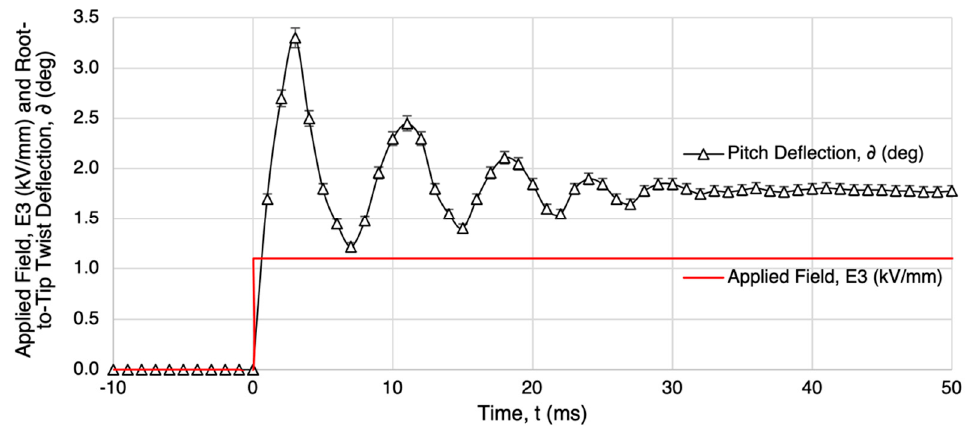
Figure 13. Root-to-tip DAP wing twist deflections with step electric field application, 0–160 ft/s (0– 49m/s), Rn 0–255,000.